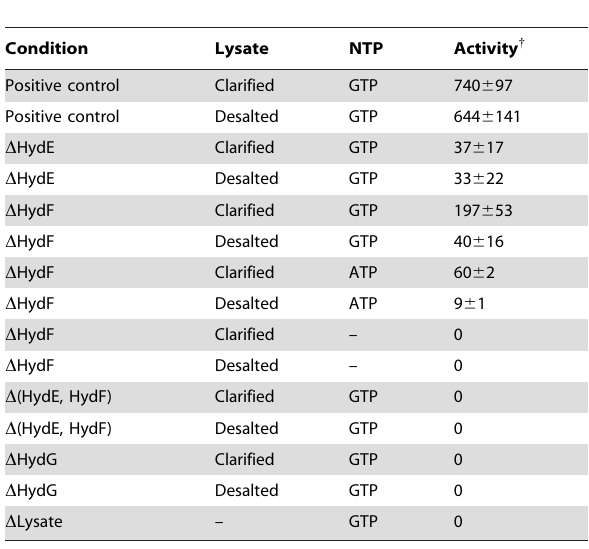
Table 2. Effects of excluding protein constituents on in vitro CpI